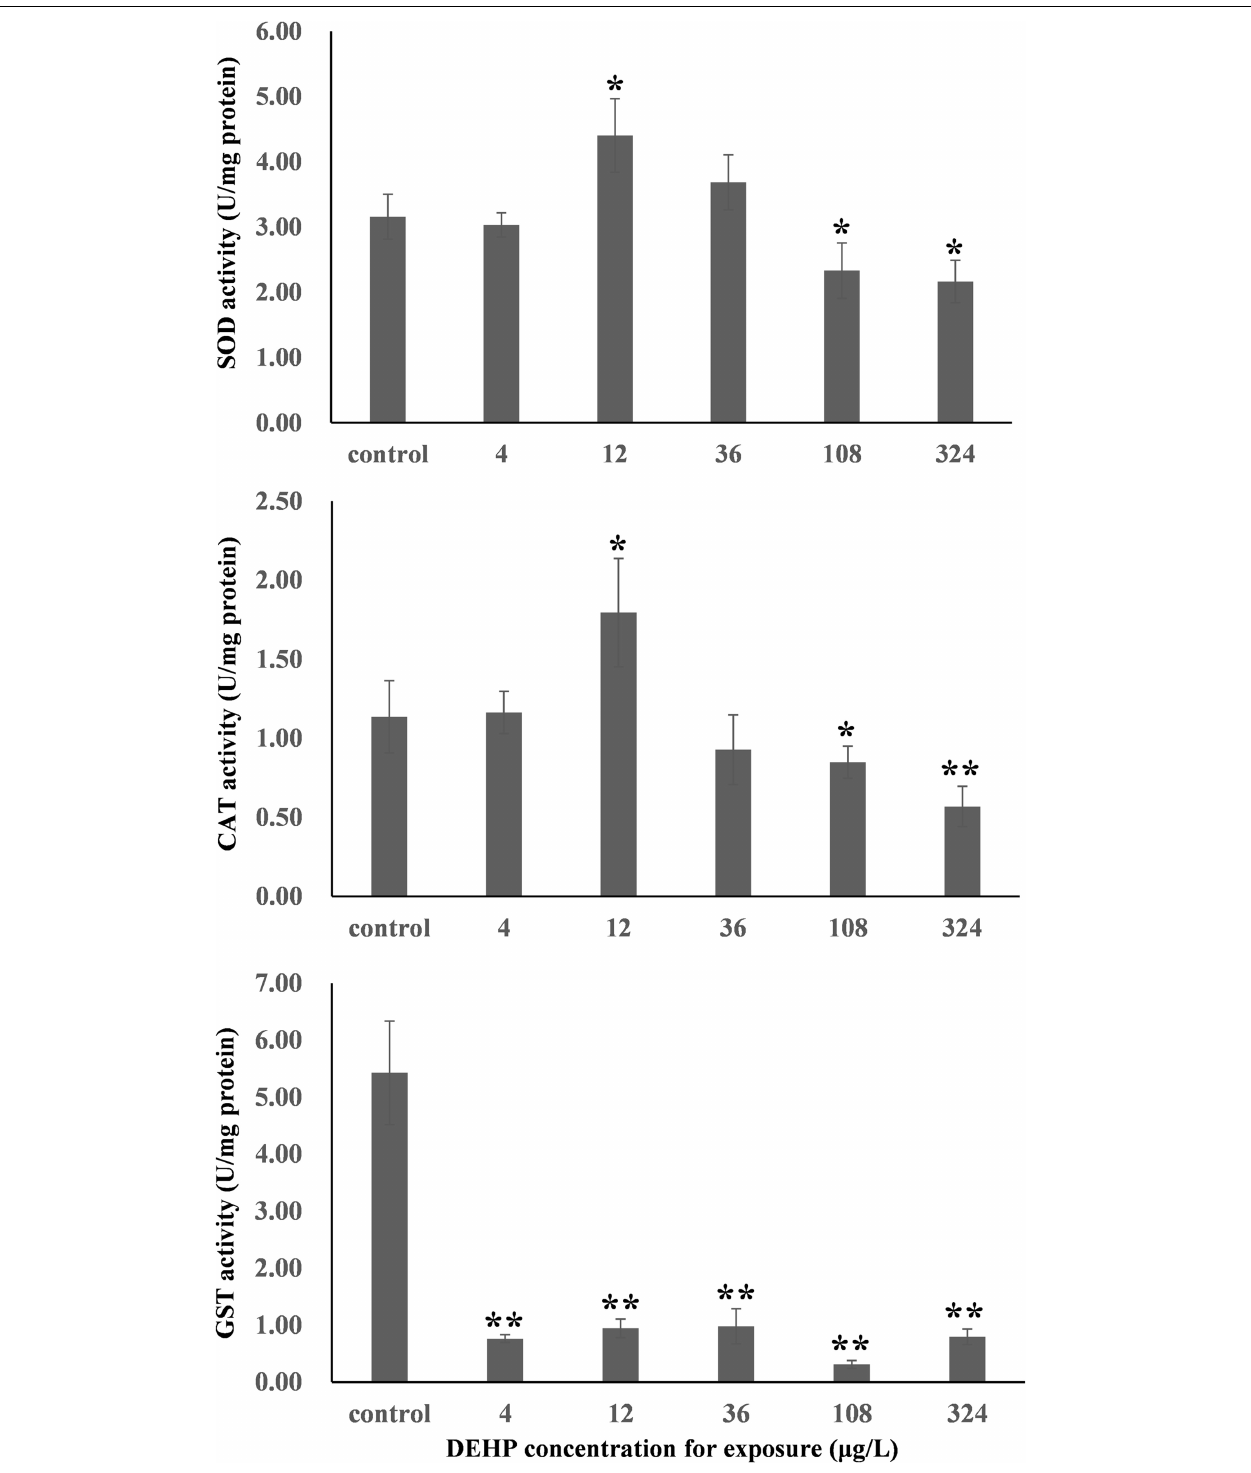
Frontiers in Marine Science |